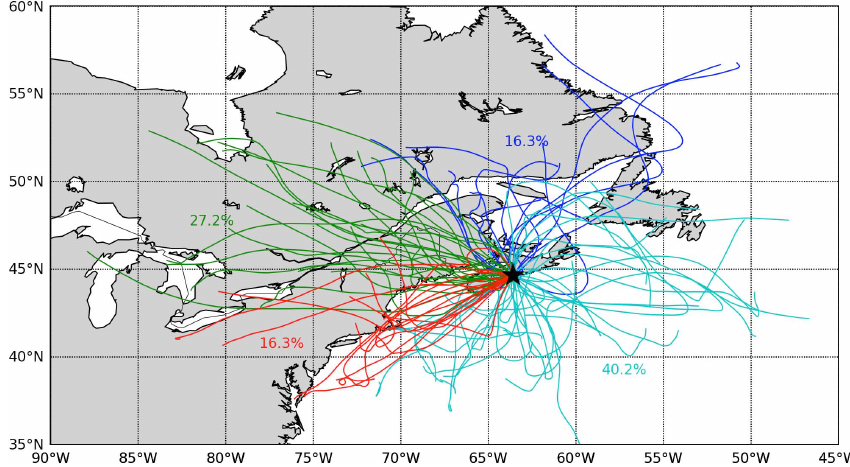
Fig. 2. Map of ensemble HYSPLIT 2-day air mass back trajectories between 11 July 2011 and 25 August 2011. Trajectories were initialised twice per day at 08:00UTC and 20:00UTC with an arrival height of 500m. Colours denote upwind source region (cyan = marine; red = SW; green = WN; and blue =